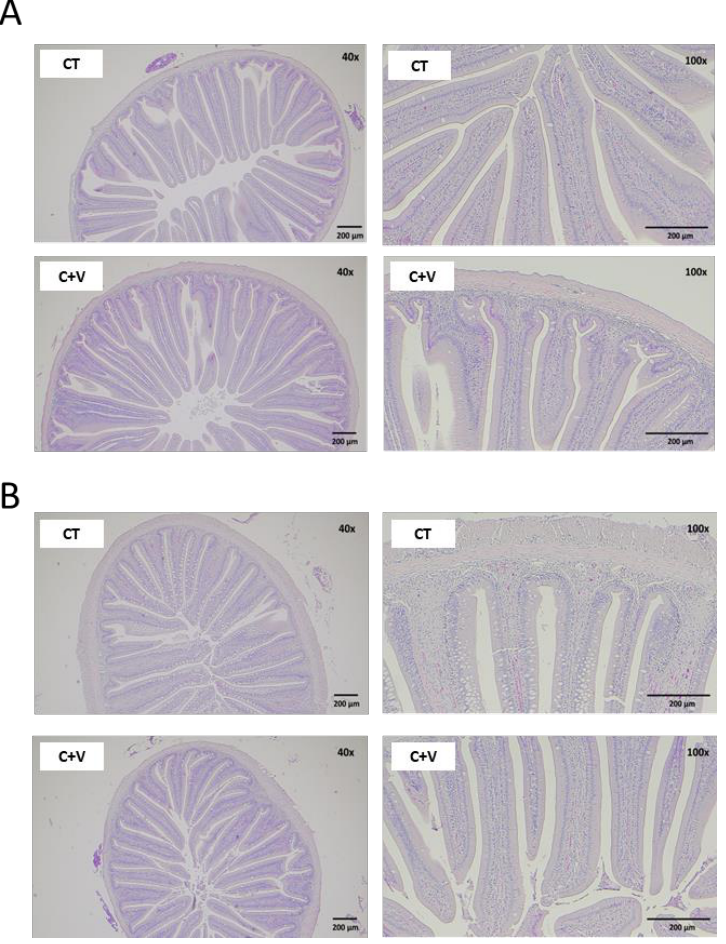
Figure 3. Light microscopy images from the proximal ( A ) and distal ( B ) regions of the intestine of juvenile C. labrosus fed the control (CT) or C. fusca + V. proteolyticus (C + V) diets for 90 days. H&E stain, magnification 40× , scale bar 200 μm; 100 × , scale bar 200 μm.